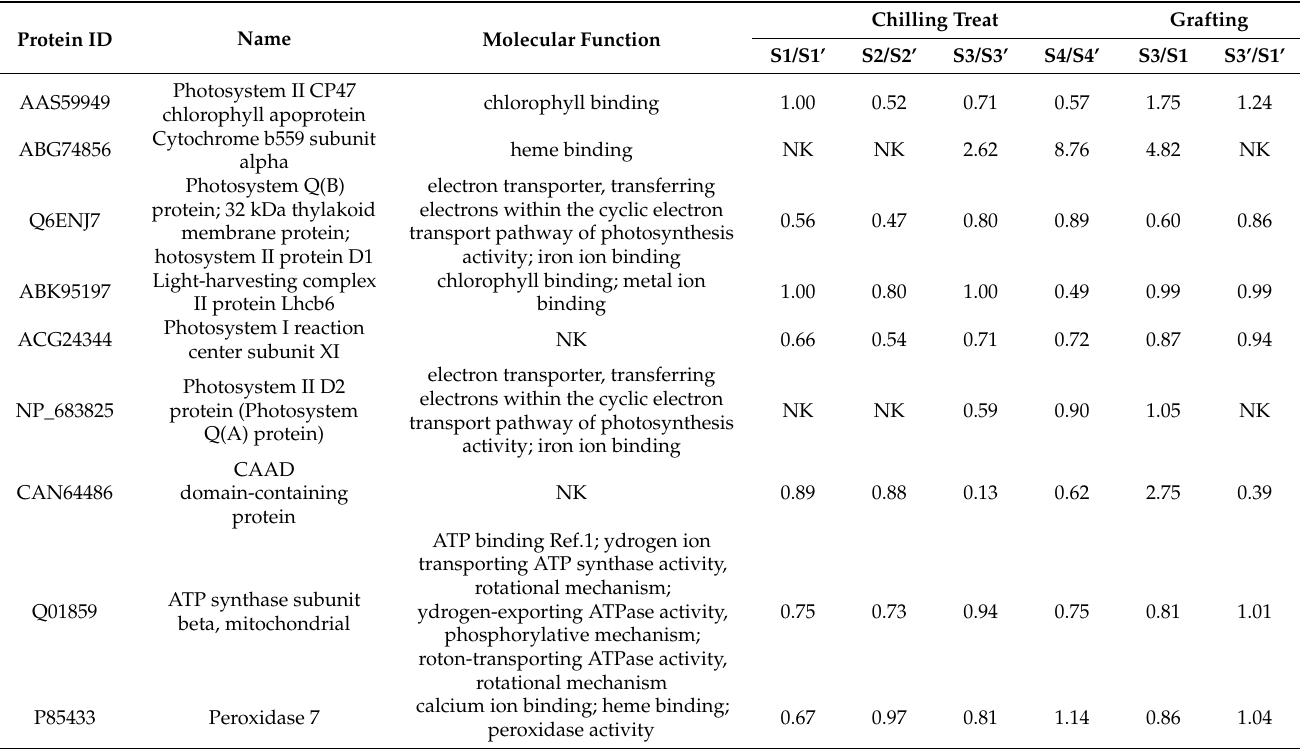
Table 8. Differential proteins related to energy metabolism in the cotton stem bark induced by chilling stress and